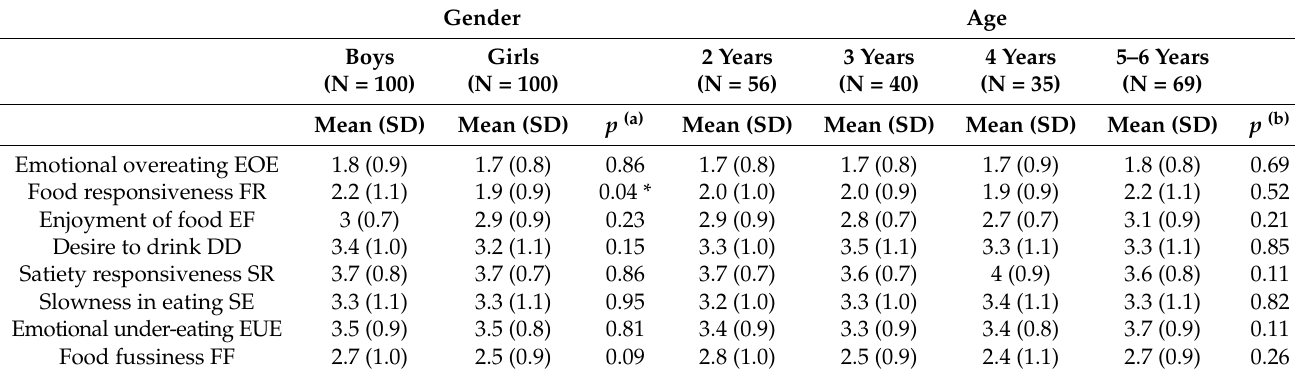
Table 5. Gender and age differences in eating behaviour, eight-factor solution (N = 200). Gender